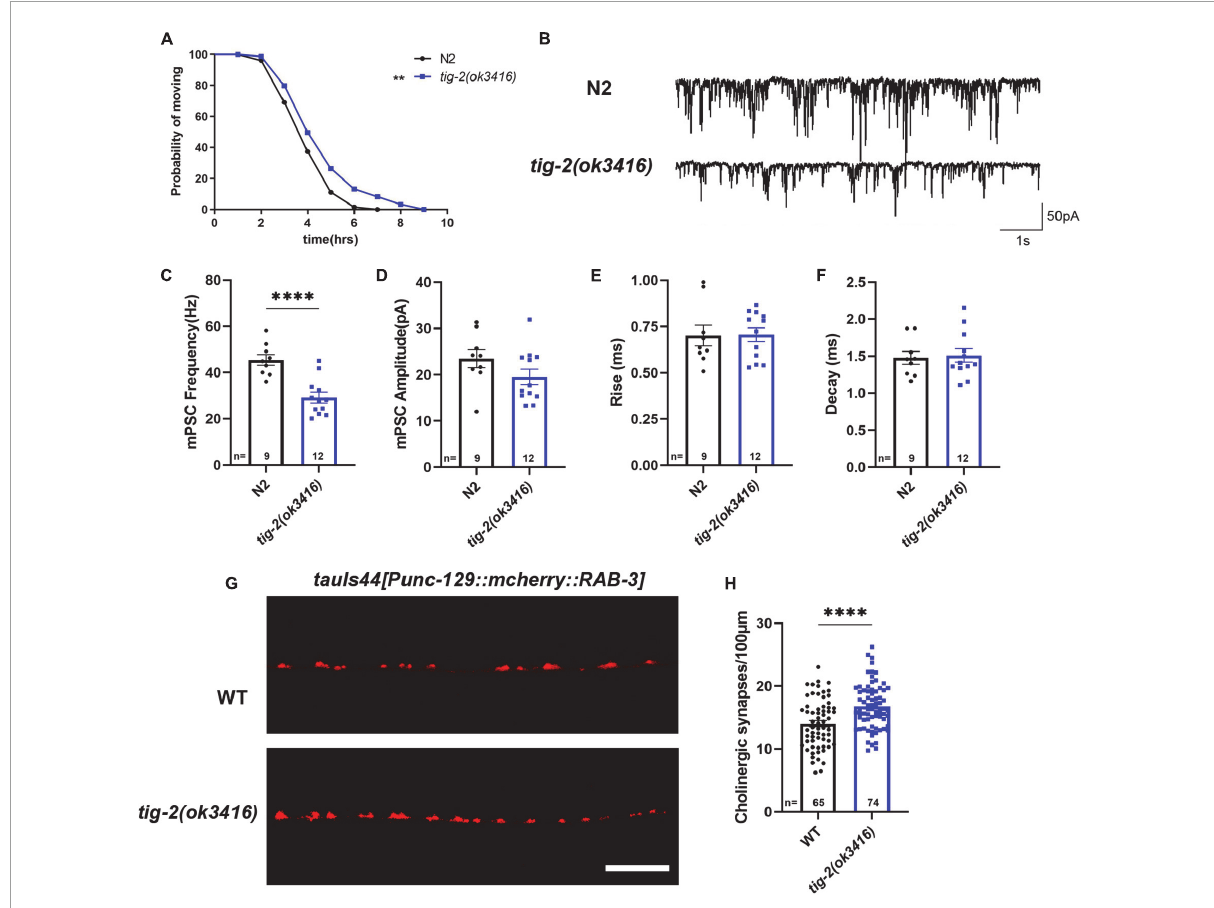
FIGURE2 tig-2 mutant has decreased acetylcholine (ACh) release but increased density of cholinergic synapses. (A) Comparison of aldicarb induced paralysis of tig-2 ( ok3416 ) mutant and wild-type worms. In early adulthood, tig-2 ( ok3416 ) mutant is more aldicarb-resistant than wild-type worms ( p = 0.0055), indicating that tig-2 mutant releases less ACh on day 3. n > 60. (B) Representative traces of miniature post-synaptic currents (mPSCs) on day 3. (C,D) The frequency of mPSC in tig-2 ( ok3416 ) mutant is lower than that in wild-type worms ( p < 0.0001), but the amplitude of mPSC is similar between tig-2 mutant and wild-type worms ( p = 0.1384). (E,F) Quantifications of the 25–75% rise time and decay time of mPSCs. The data shows that no significant difference between wild-type and tig-2 ( ok3416 ) mutant. (G) Images of the cholinergic synapses on the nerve code. (H) Images of tauIs44 strain show that the density of cholinergic synapses on the nerve cord is increased in tig-2 ( ok3416 ) mutants ( p < 0.0001). A student’s t -test was performed to determine the significance of differences in mean density. Error bars represent SEM. ∗∗ p < 0.01, ∗∗∗∗ p <